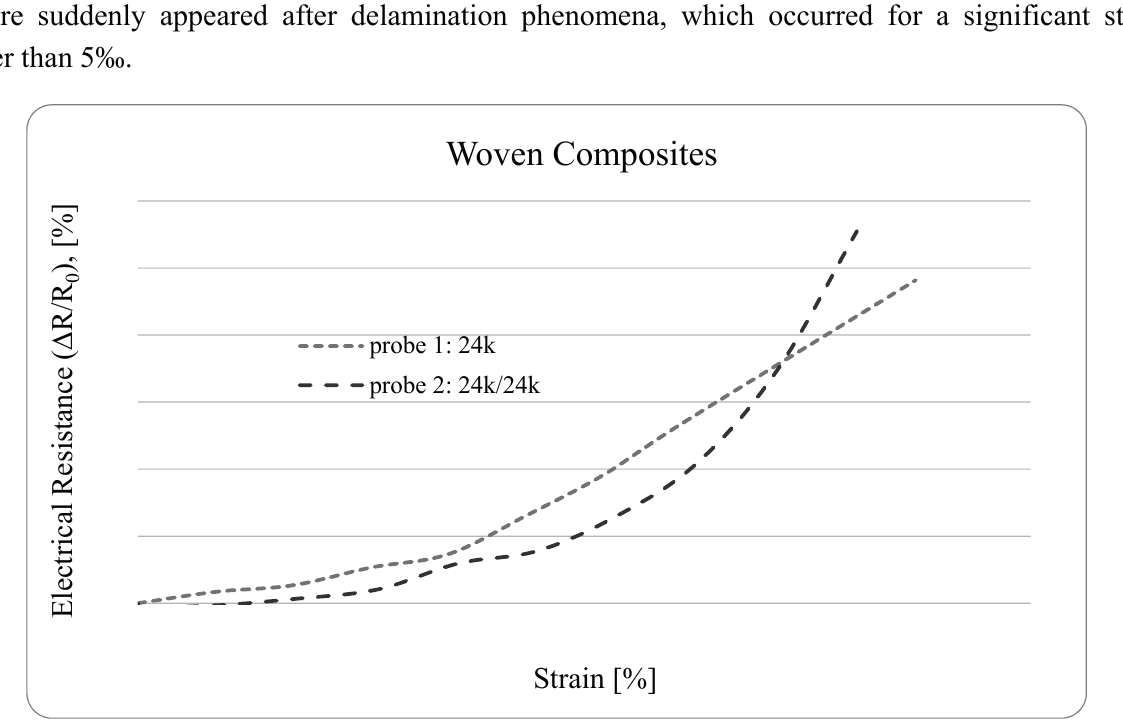
Figure 7. The relative electrical resistance versus strain of Textile Woven Epoxy